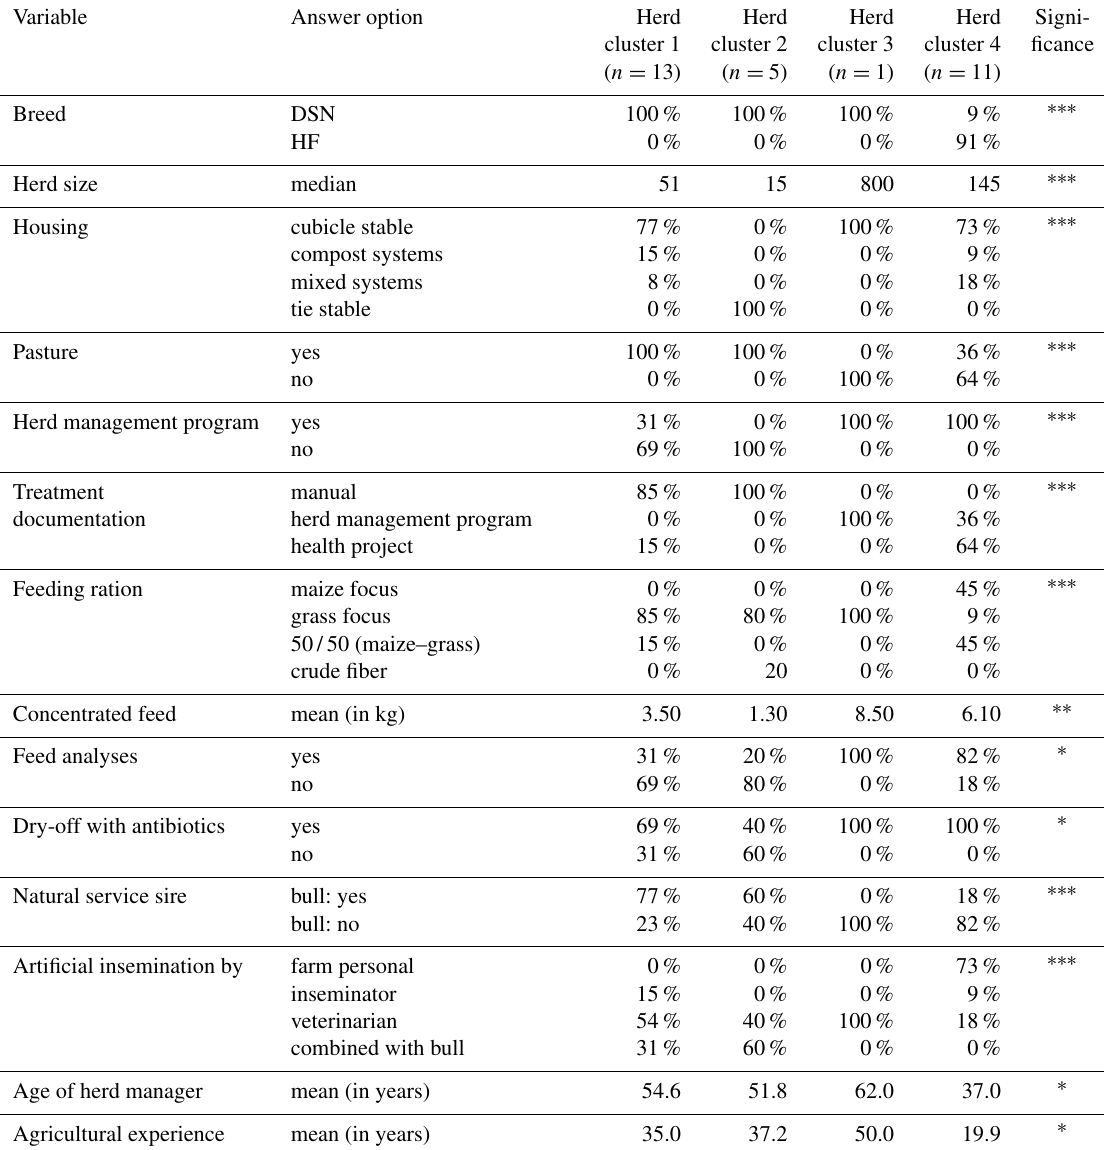
Table 2. Percentages and values of main herd characteristics displaying significant 1 herd cluster differences.